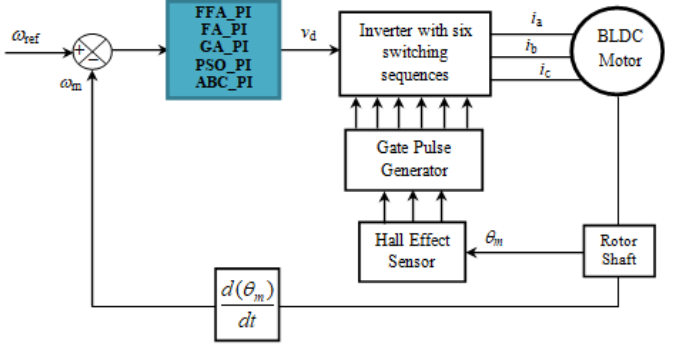
Figure 8. Speed control principle of BLDC motor.